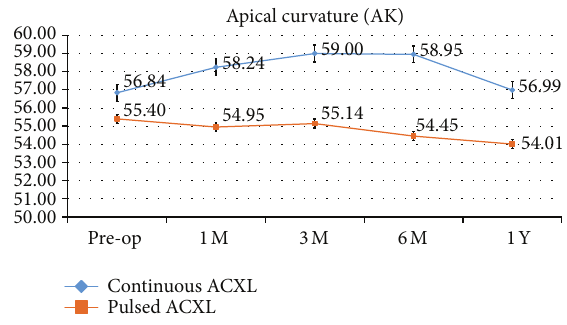
Figure 4: Topographic derived apical curvature value (AK) after continuous light (blue line) and pulsed light (orange line) acceler- ated crosslinkingshowed a statisticallysignificant decrease inpulsed light accelerated CXL by a mean value − 1.39 Diopters at one-year follow-up; no statistically significant differences were recorded in AK value after continuous light accelerated CXL.